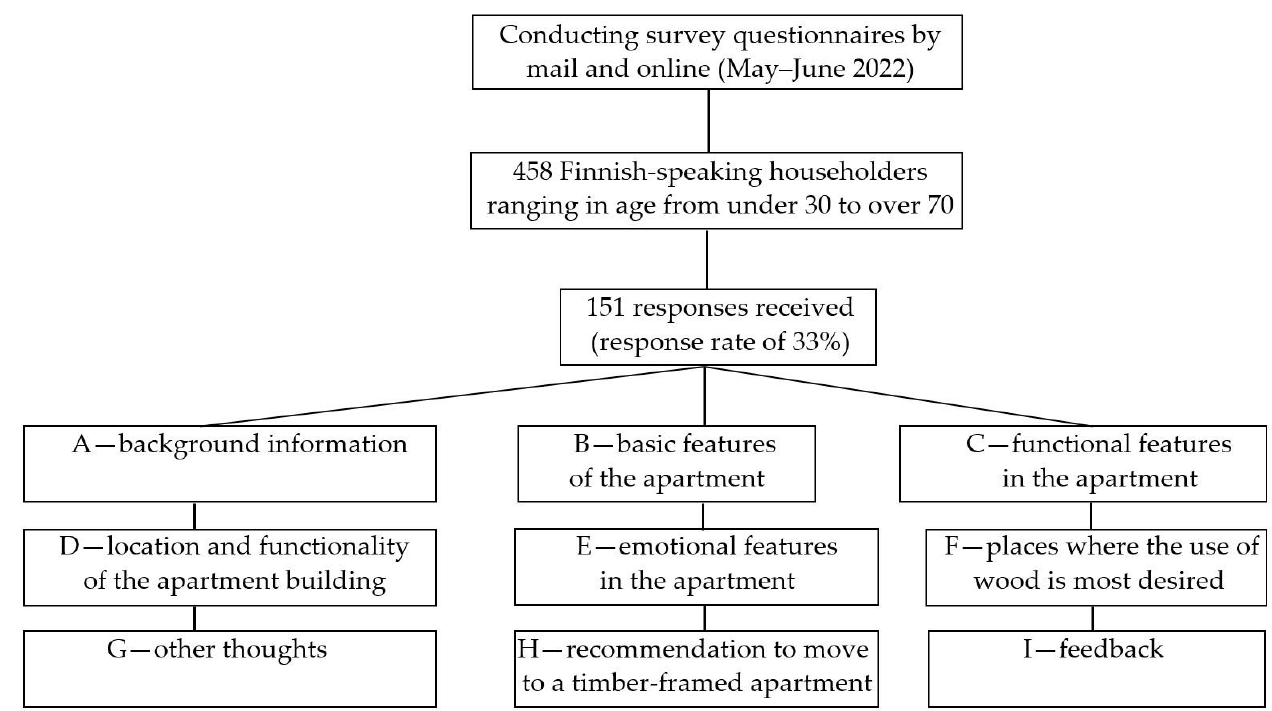
Figure 13. Research methodology.